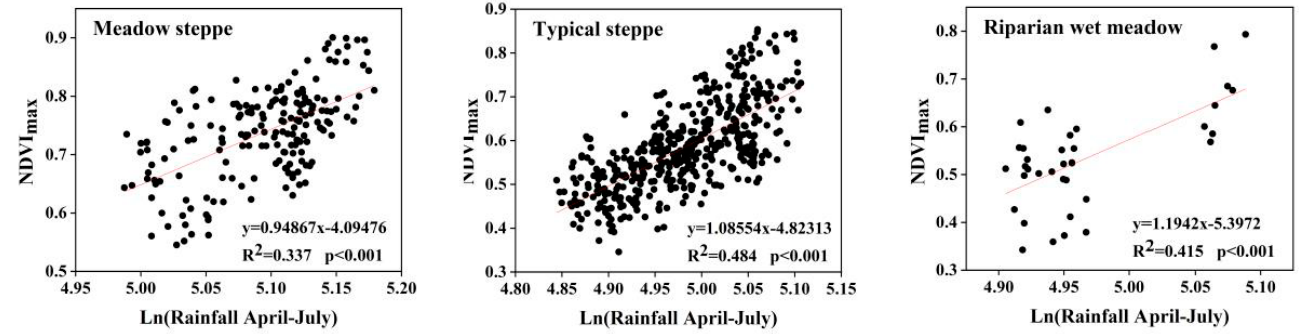
Figure 7. Correlation between NDVI max and precipitation from April to July for different ecosystem types.